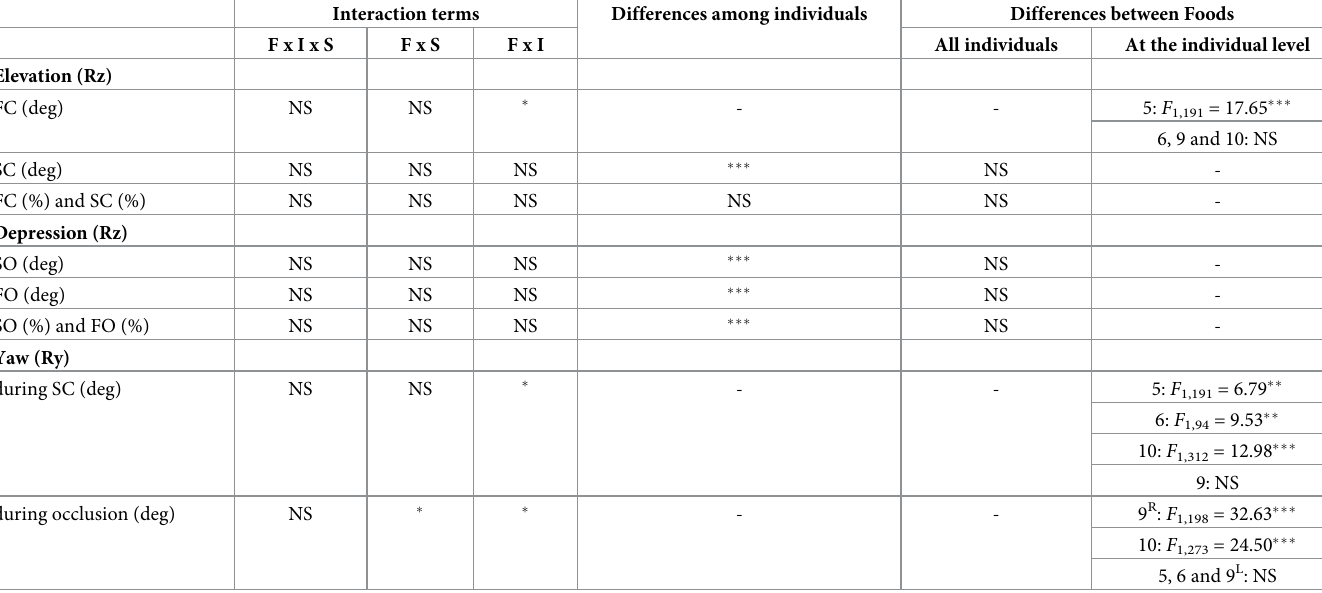
Table 4. Summary of the effects of food stiffness (i.e., carrot versus almond) on the amplitude of jaw movements. Interaction